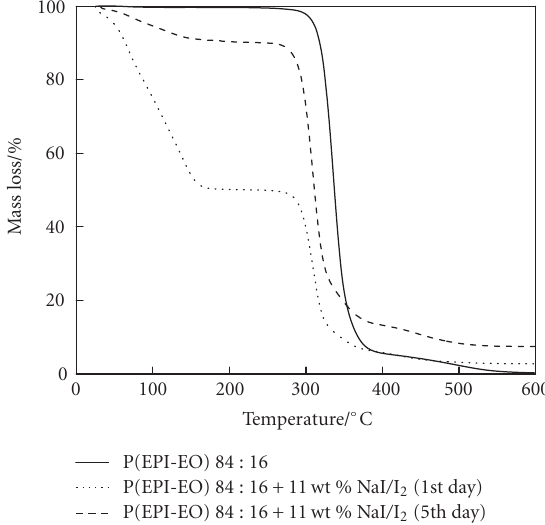
Figure 1: The variation of energy conversion e ffi ciency under 100 mWcm − 2 as a function of time for a solid-state DSSC assem- bled with a P(EPI-EO) + 11wt% NaI / I 2 polymer electrolyte de- posited by casting under a saturated solvent atmosphere ( (cid:2) ) and deposited by casting at 60 ◦ C ( (cid:3) ).